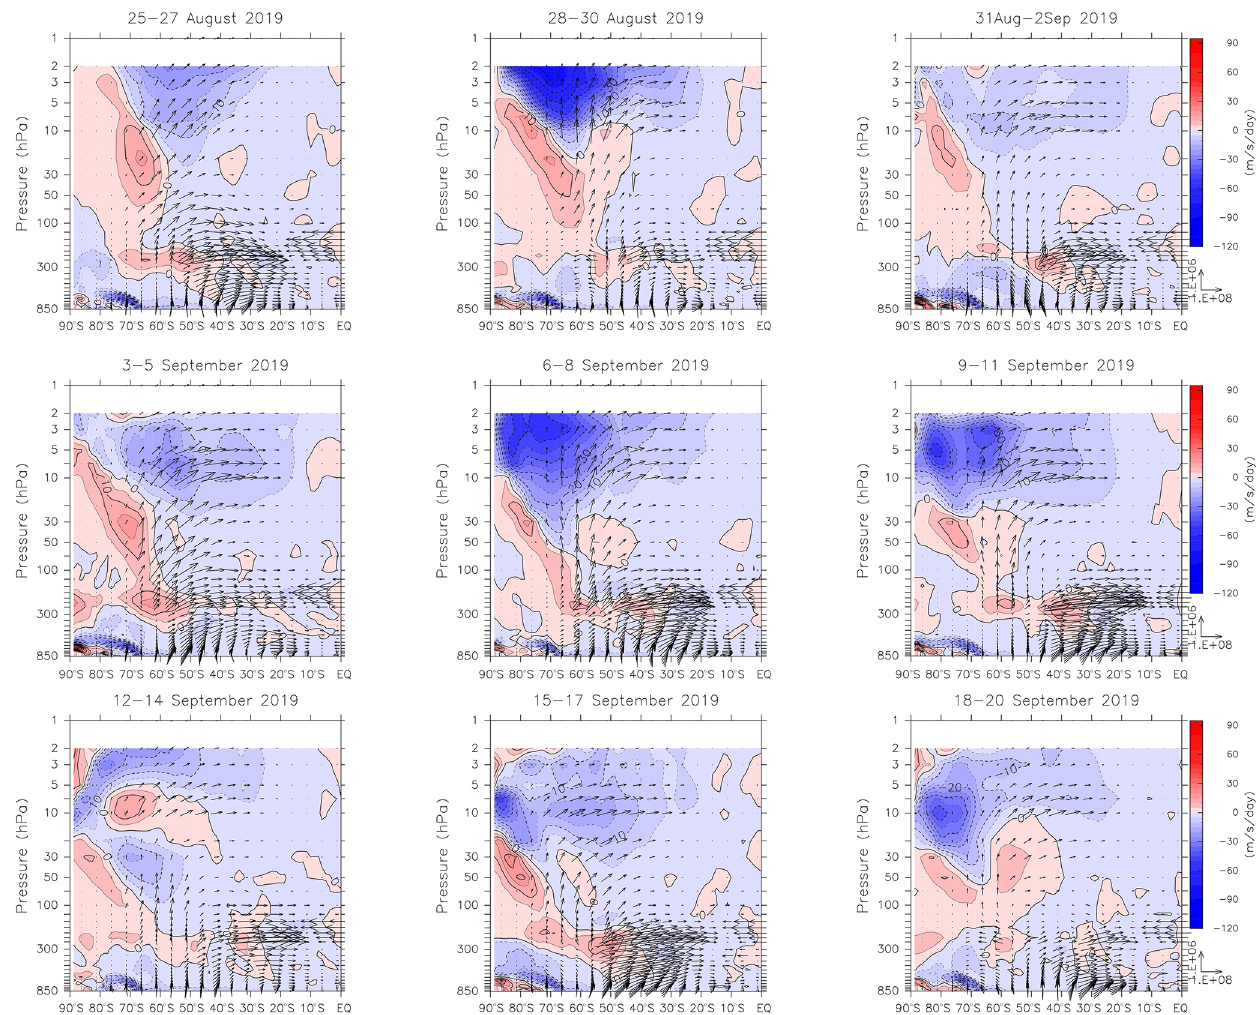
Figure 7. Same as Fig. 5 but for E–P flux (kgs − 2 ) (vectors) and the wave driving due to its divergence (ms − 1 d − 1 ) (color shading). Contour intervals are 5ms − 1 d − 1